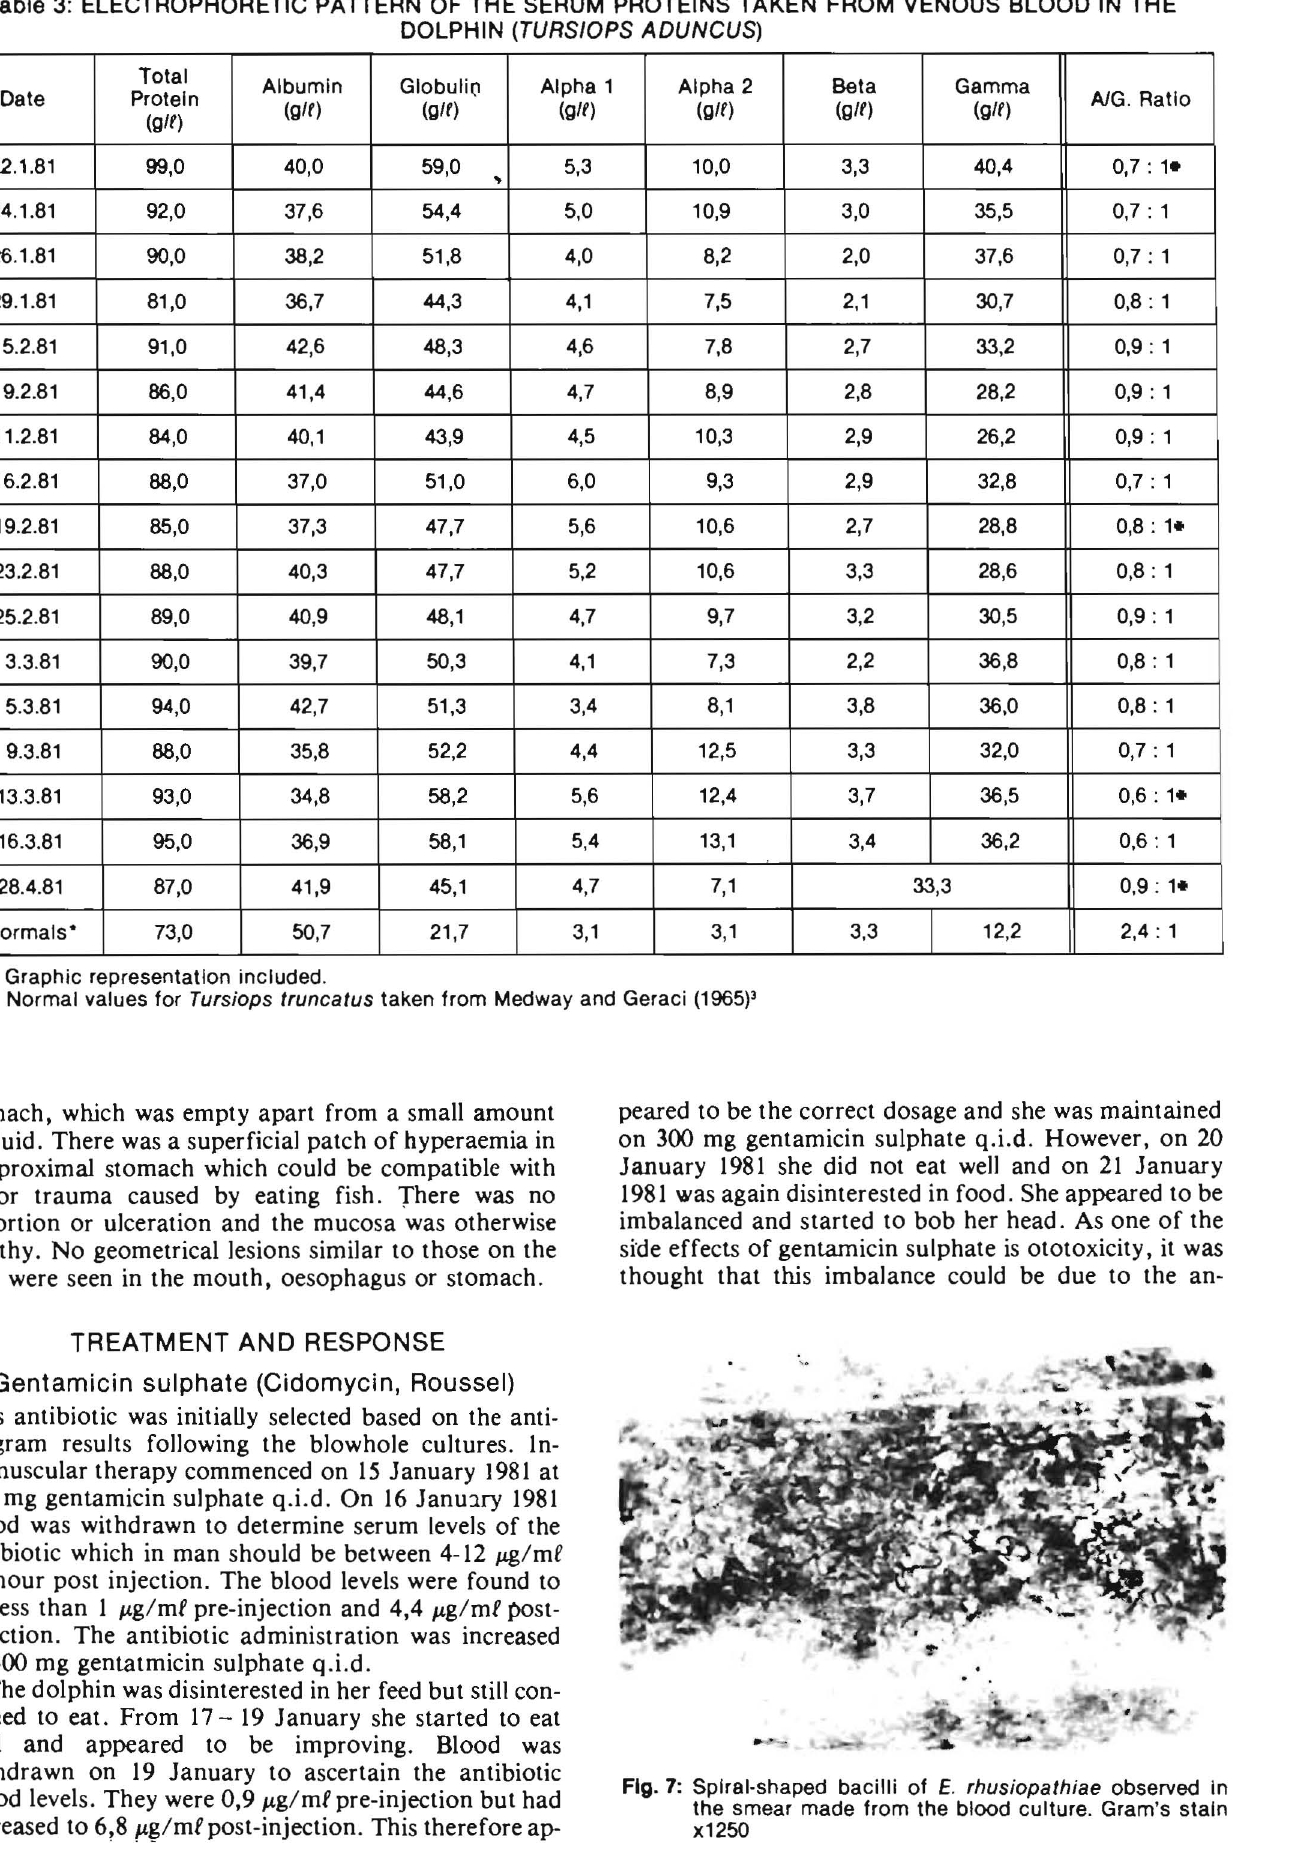
Fig. 7: Spiral-shaped bacilli of E. rhusiopathiae observed In the smear made from the blood culture. Gram's stain